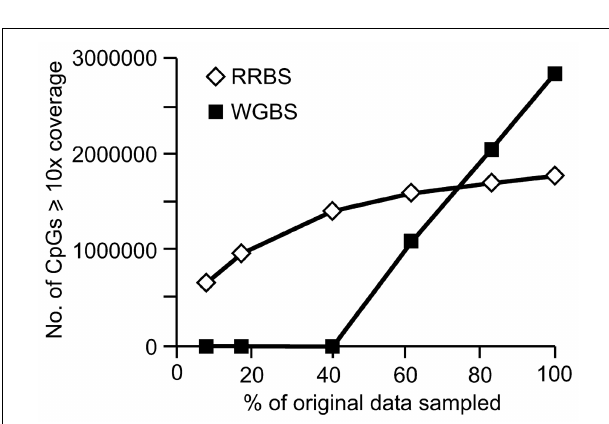
FIGURE 6 | CpGs with at least 10x coverage in data sets generated from RRBS versusWGBS.